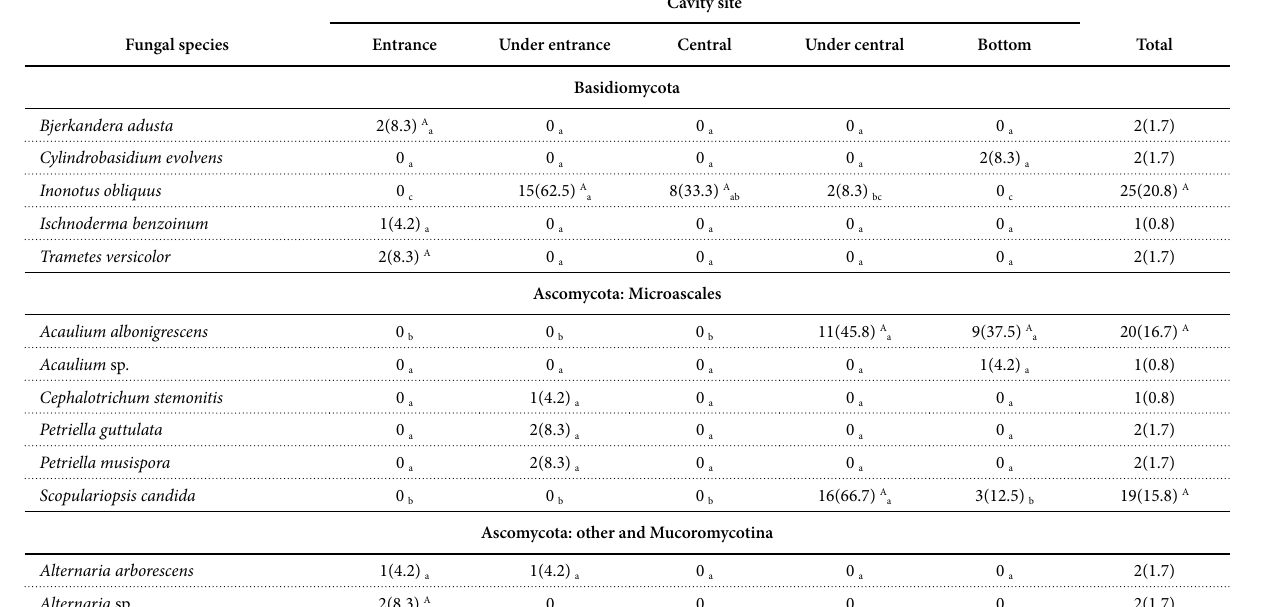
Tab. 3 Number of isolates and frequency of fungi (in parentheses*) isolated from the Fagus sylvatica cavity excavated by Dendrocopos leucotos